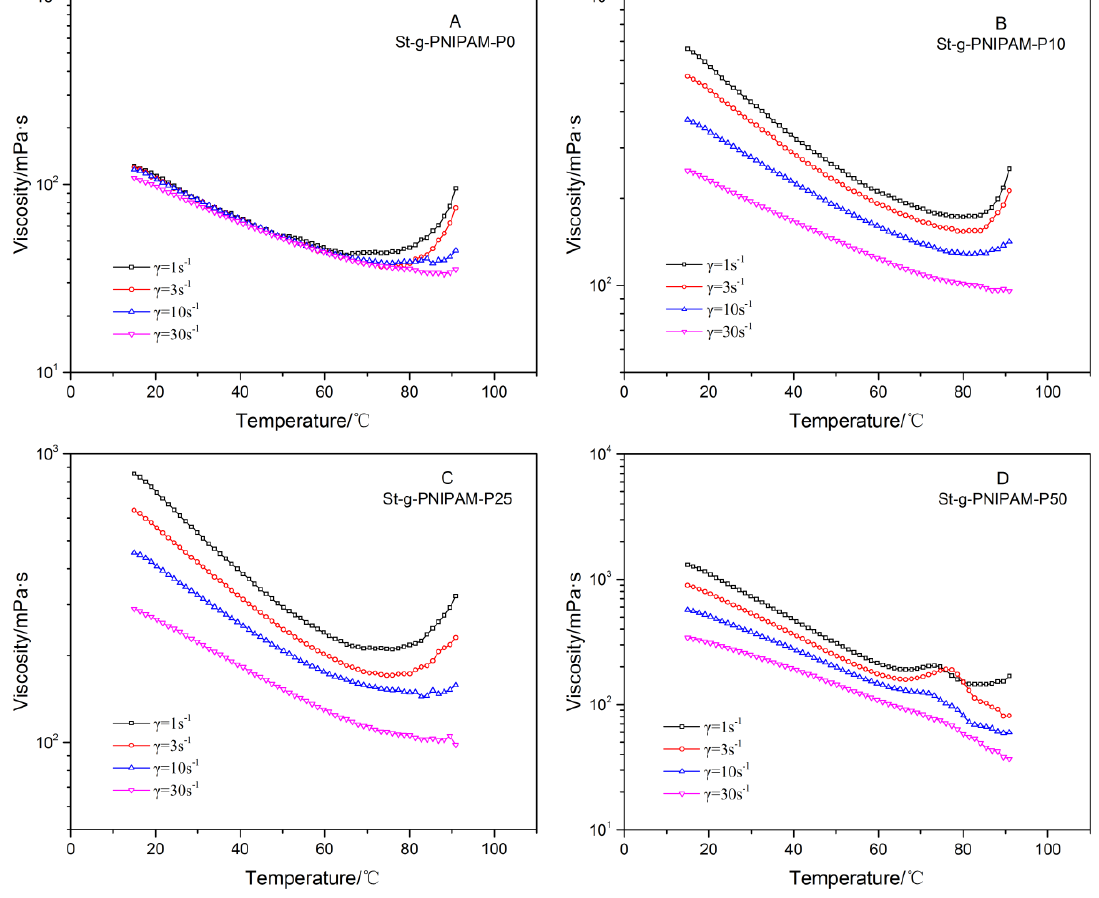
Figure 6. Influence of composition and salt concentration on polymers’ viscosity (γ = 10 s −1 ) ( Left ) and cloud point ( Right ) with 1 wt % copolymer solution. In the case of the cloud point, as shown in Figure 6 (Right), copolymers with a low NIPAM ratio (10 mol % and 25 mol %) displayed no phase transition in the temperature range of 20 °C to 95 °C. The addition of salt has no significant influence on their cloud point. St-g-PNIPAM-P50, however, has a cloud point at around 68 °C (50 mol % of the transmittance) due to high NIPAM content. The addition of NaCl (100,000 ppm) shifted the cloud point to 45 °C.